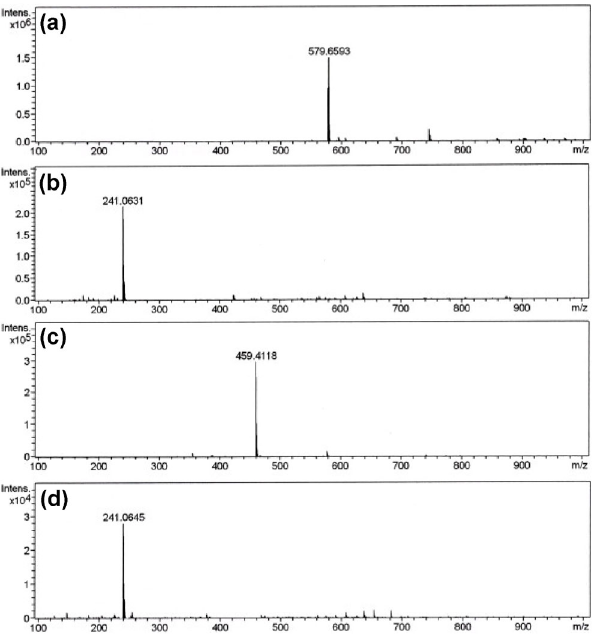
Fig. 2 Time-of-flight mass spectrometry of N 88816 S P and P 888S S P : (a, c) describe the cations [N 88816 ] + and [P 888S ] + and (b, d) describe the anions of [SP] –